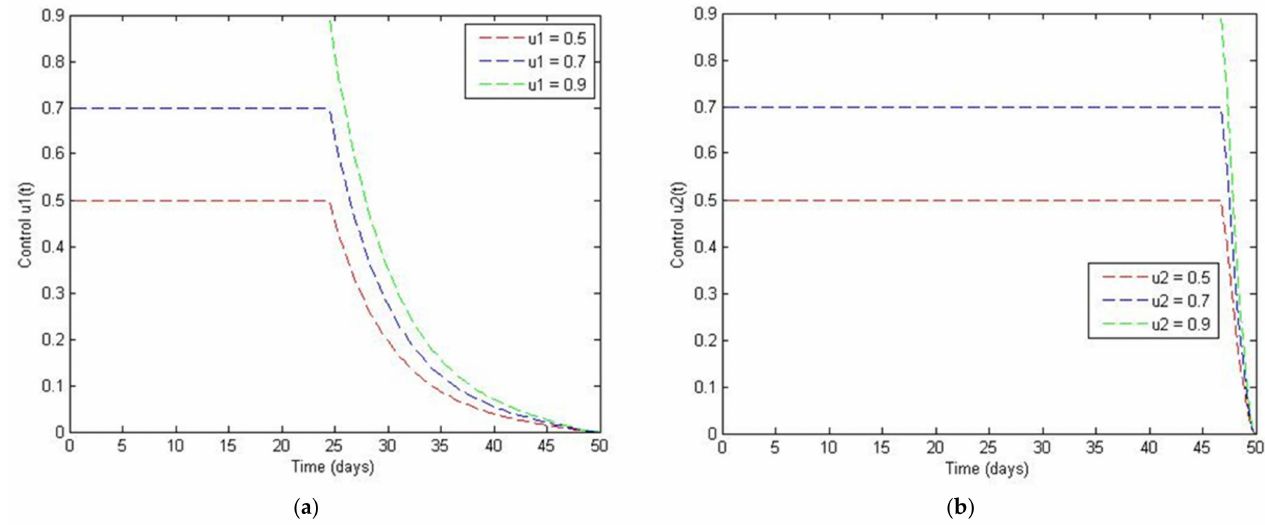
Figure 16. Simulation results of the control: ( a ) The vaccination rate u 1 ( t ) and ( b ) the Aegypti breeding destroying rate u 2 ( t ) when X 1 = 100, X 2 =